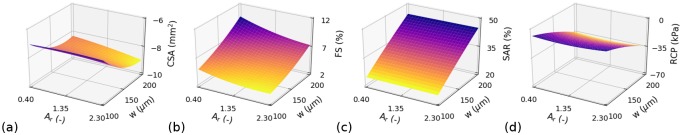
Response surfaces highlighting the combined influence of Ar and w on each performance metric (CSA, FS, SAR and RCP), holding t and l constant at their baseline values (t = 150 μm and l = 1050 μm).